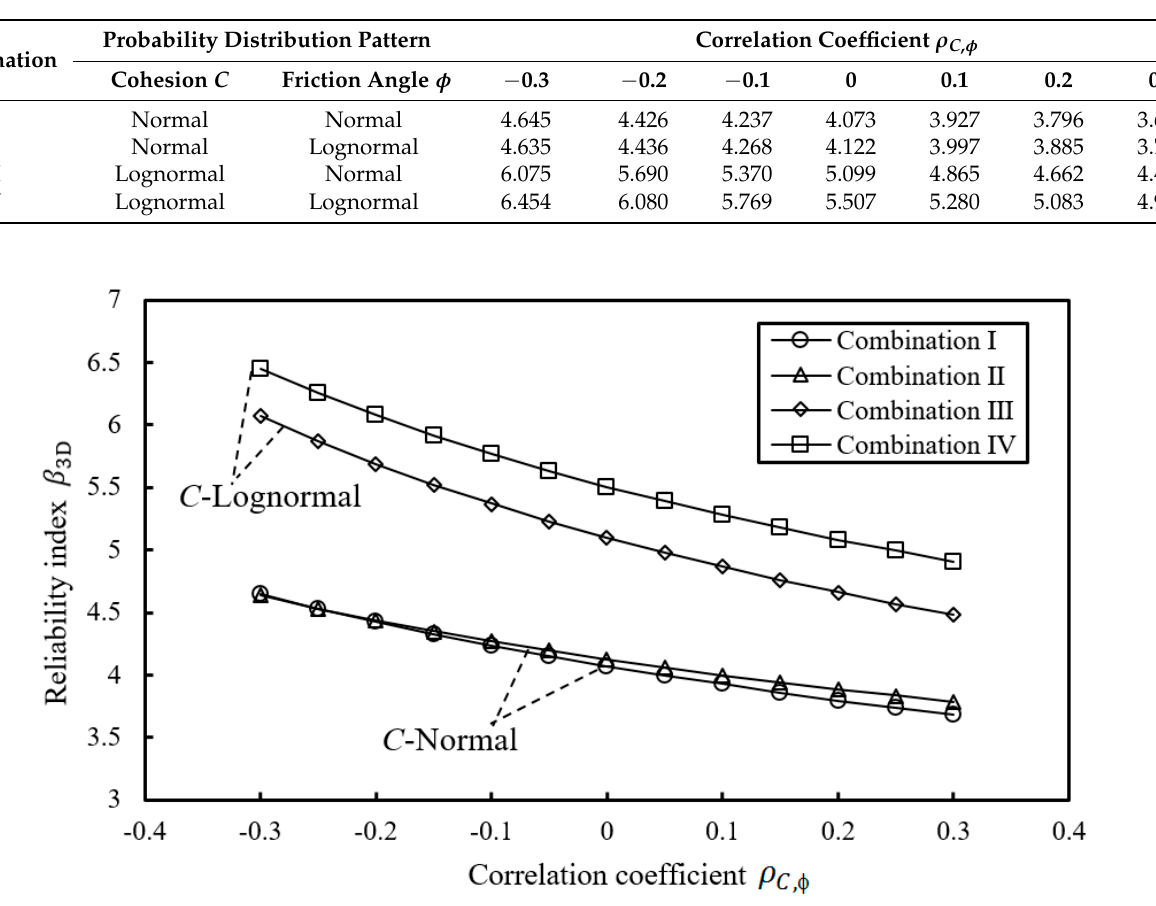
Figure 9. Variation in slope reliability index versus correlation coefficient.